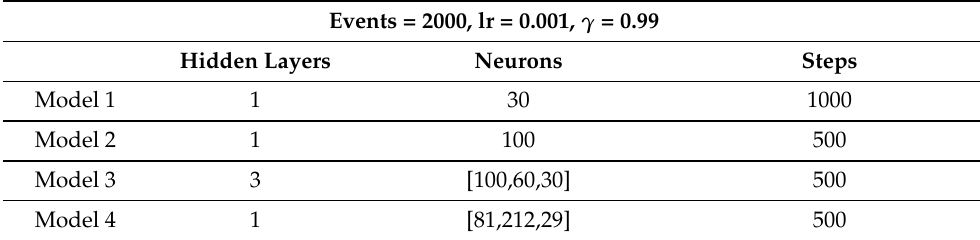
Table 2. DQN models and hyperparameters set during the training